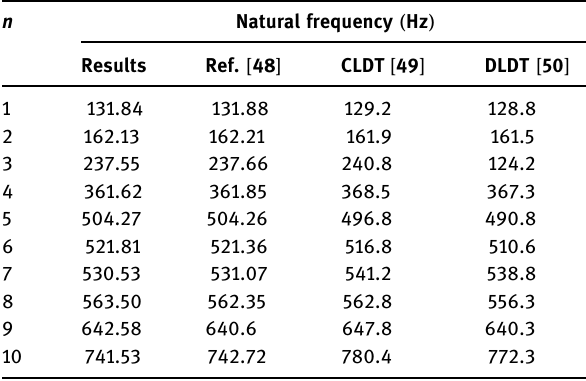
Table 1: Comparison of natural frequency of composite laminate